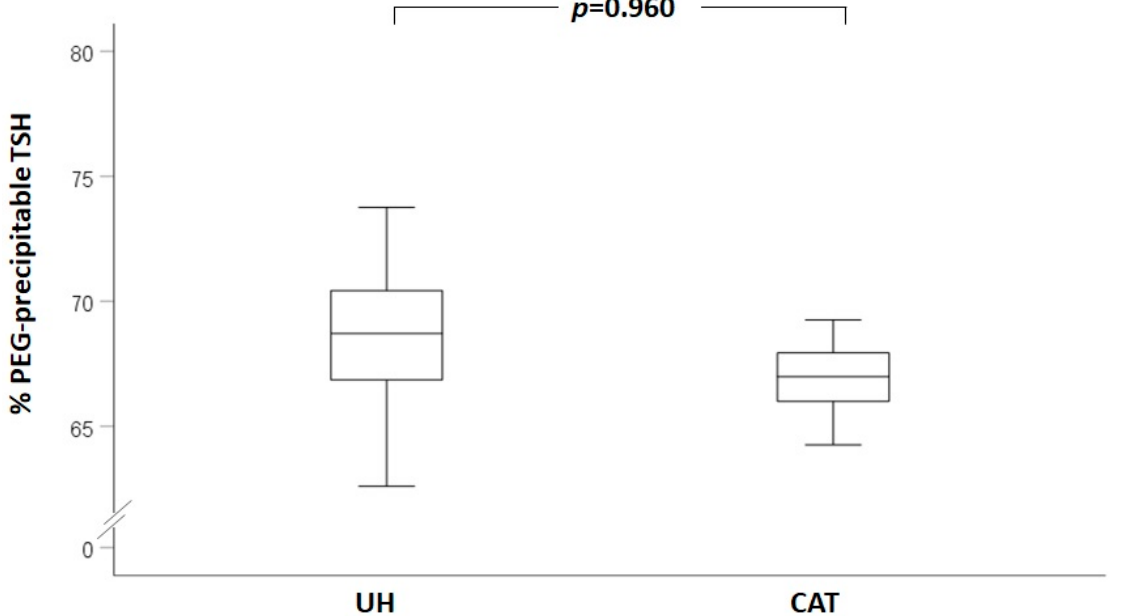
Figure 1. Box plot representing the percentage of PEG-precipitable TSH in the unexplained hyperthyrotropinemia (UH) and chronic autoimmune thyroiditis (CAT) groups.